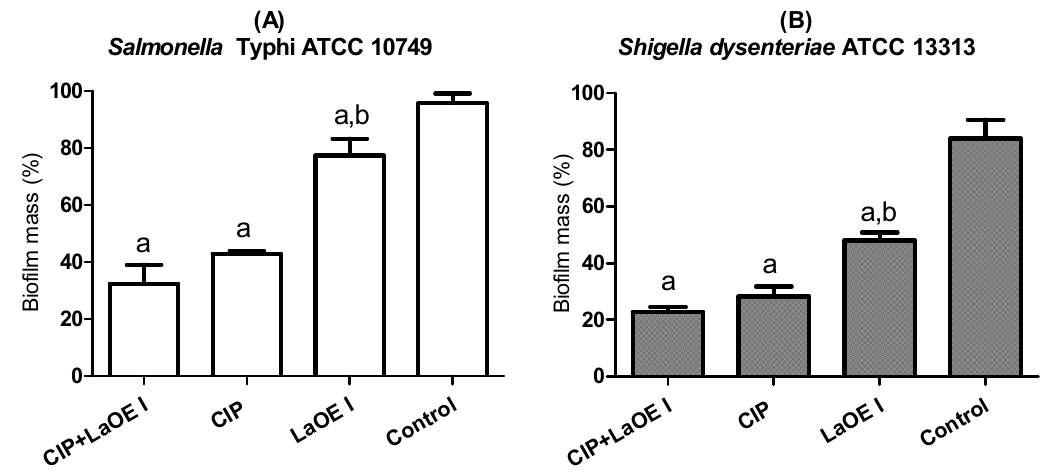
Figure 4. Inhibition of Salmonella typhi ( A ) and Shigella dysenteriae ( B ) biofilm formation by the association LaEO I-CIP. Values is expressed as mean ± SEM of two assays. The analysis was performed by ANOVA, with Dunnett’s post-test and a p value < 0.05 when compared to the control (a) and a p value < 0.05 when compared to the CIP+LaEO association (b). Control: culture medium + microorganism; MIC LaEO I = 1 mg/mL; MIC CIP = 0.25 μg/mL; and FICI LaEO I-CIP = 0.125 (lowest concentrations of the LaEO I and CIP association, with antimicrobial activity = 1/16 × MIC).